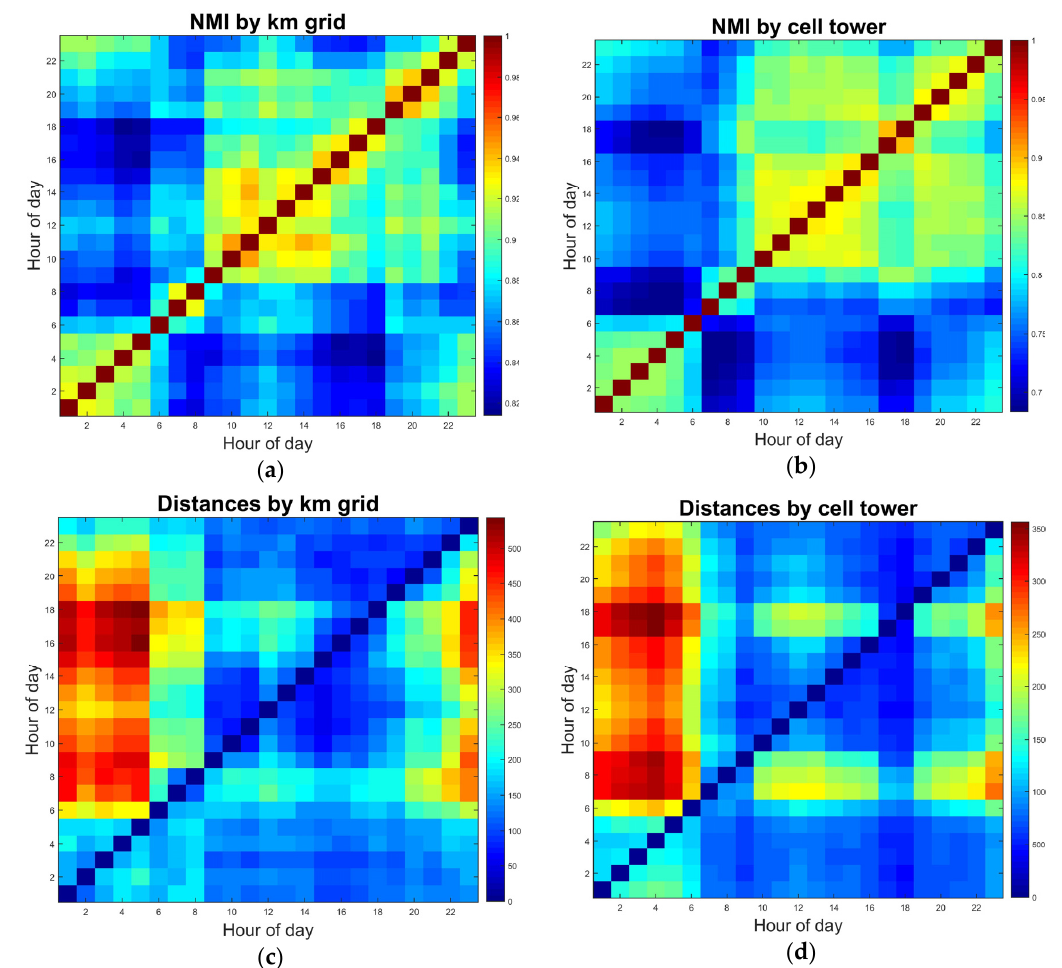
Figure 10. Comparisons among structures at different hours using different units and two metrics: ( a ) NMI by grid cells; ( b ) NMI by individual cell towers; ( c ) “split-join” distance by grid cells; and ( d ) “split-join” distance by individual cell towers.